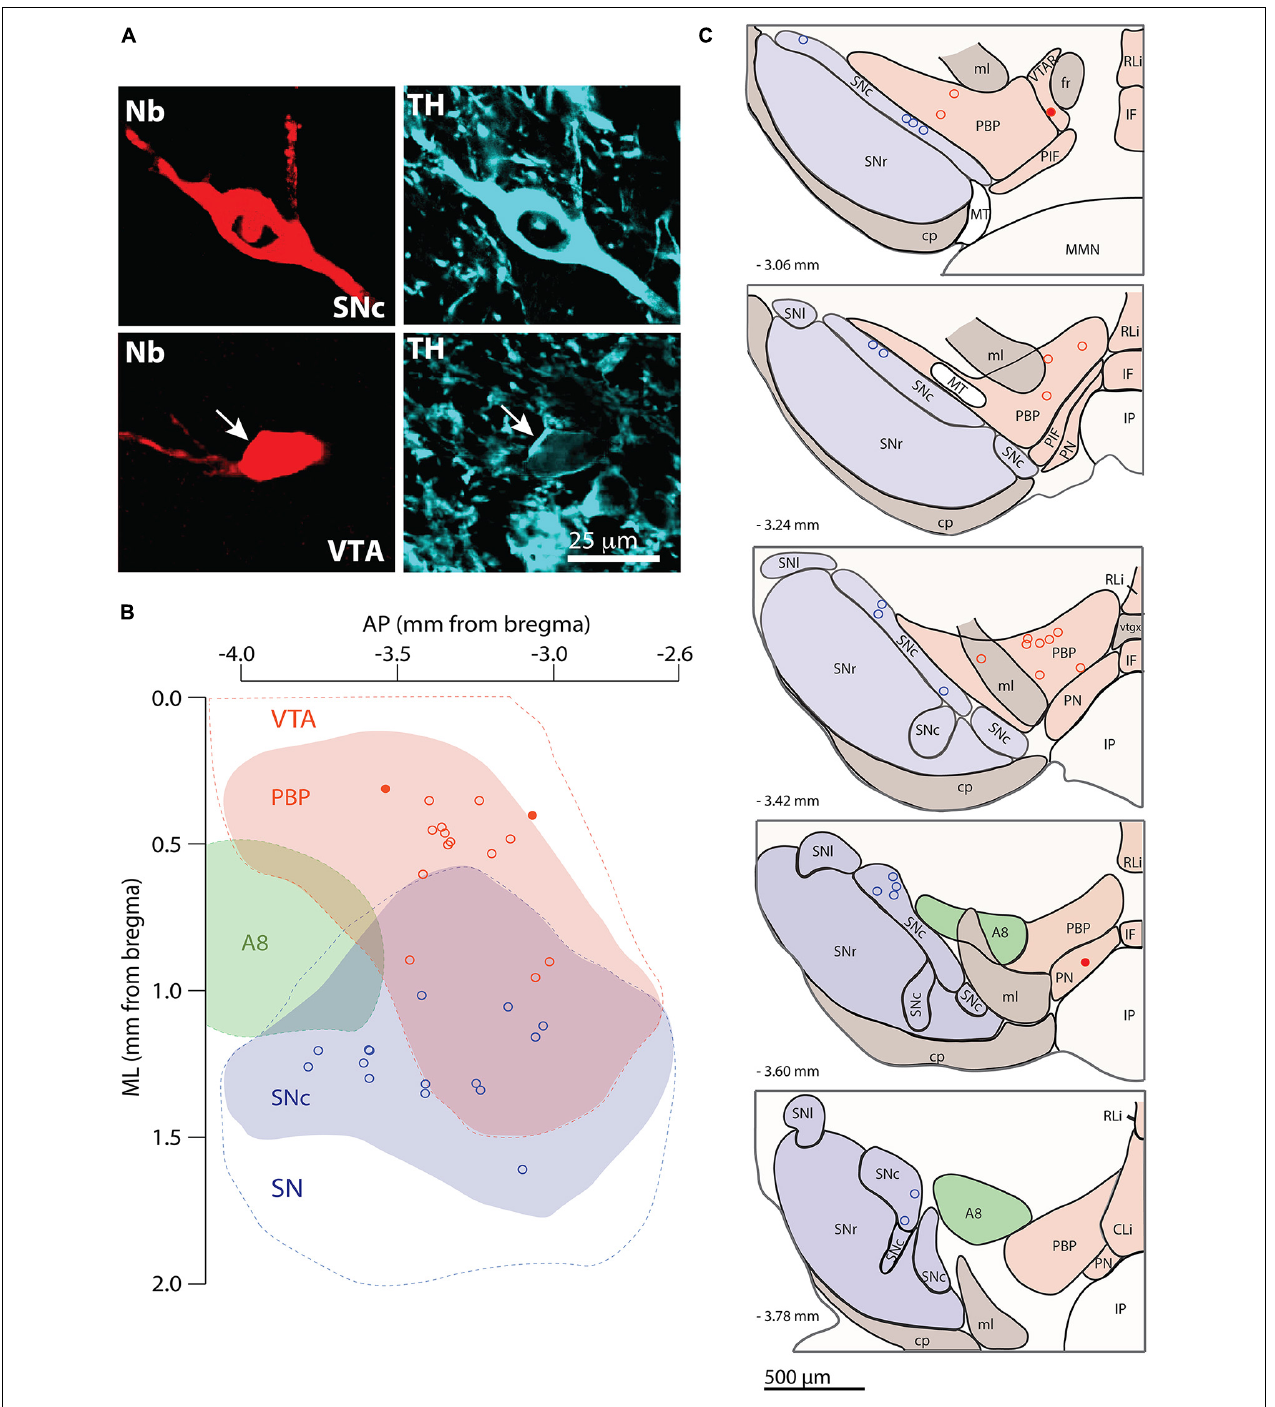
FIGURE 1 | Labeling, identification, and cell body localization of dopaminergic (DA) neurons. (A) SNc (top) and VTA (bottom, arrow) neurons were labeled with neurobiotin (red, left) and expressed tyrosine hydroxylase immunoreactivity (cyan, right, arrow in bottom image). (B,C) Location of cell bodies of the 15 SNc and 15 VTA DA neurons used in this study in one (B) dorsal and five (C) frontal views. Blue, red, and green shades indicate the SNc, PBP, and A8 groups, respectively. Blue and red dashed lines indicate the substantia nigra and VTA regions, respectively in panel (B) . AP, anteroposterior; ML, mediolateral; CLi, caudal linear nucleus; cp, cerebral peduncle; fr, fasciculus retroflexus; IF, interfascicular nucleus; IP, interpeduncular nucleus; ml, medial lemniscus; MMN, medial mammillary nuclei; MT, medial terminal nucleus; PBP, parabrachial pigmented nucleus; PIF, parainterfascicular nucleus; PN, paranigral nucleus; RLi, rostral linear nucleus; SN, substantia nigra; SNc, substantia nigra pars compacta; SNl, substantia nigra compacta pars lateralis; SNr, substantia nigra pars reticulata; VTAR, rostral VTA.